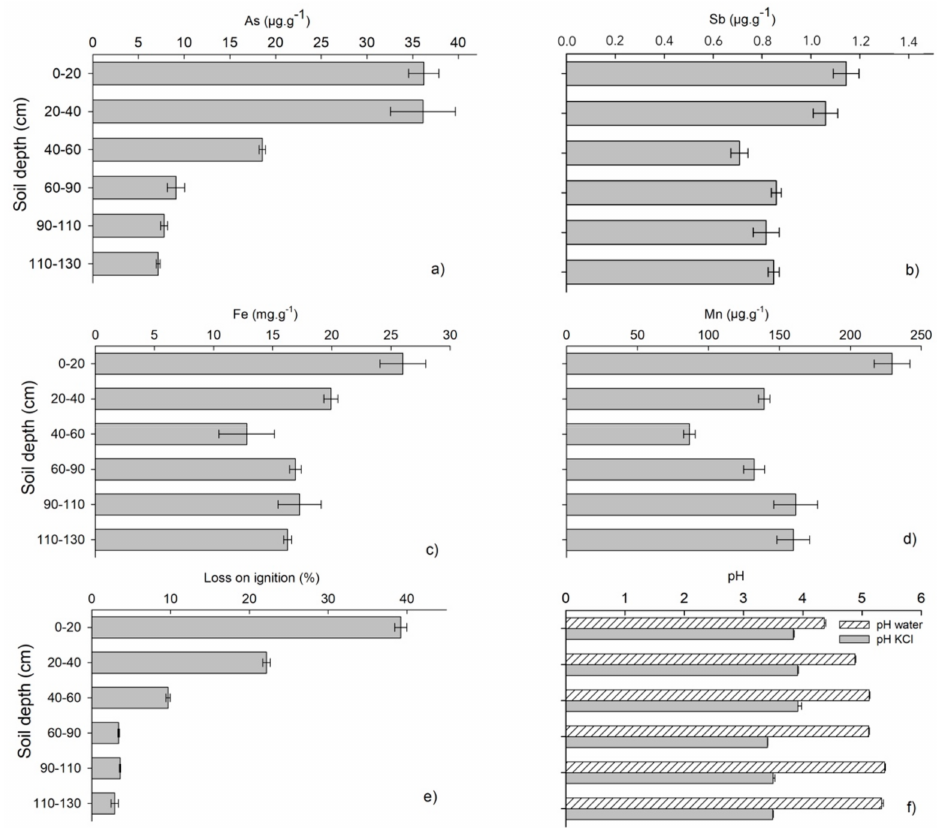
Figure 2. Total concentrations of As ( a ), Sb ( b ), Fe ( c ) and Mn ( d ); loss on ignition ( e ) and pH ( f ) along the soil depth. Bars are represented as the mean value ± standard variation ( n =